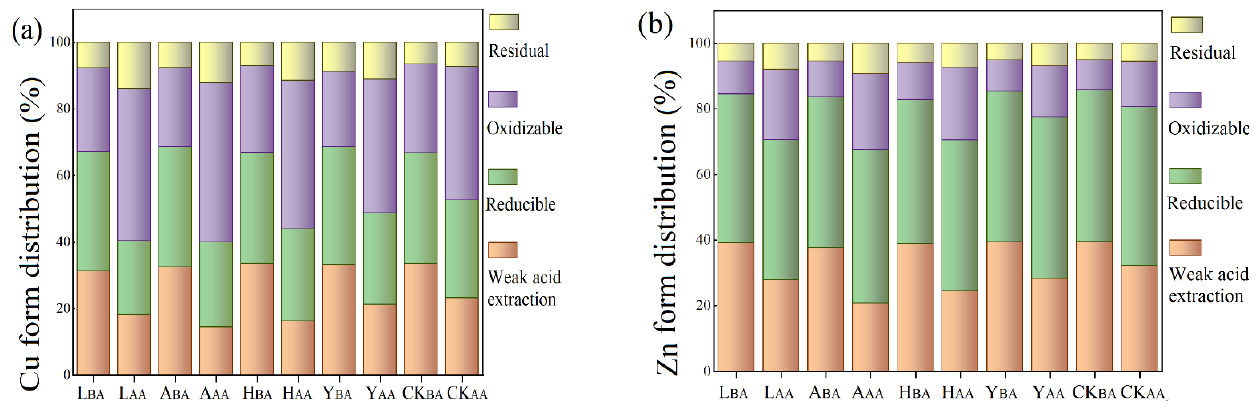
Figure 4. Effects of different inorganic passivators on the distribution of the form of ( a ) Cu and ( b ) Zn. BA: before anaerobic digestion; AA: after anaerobic